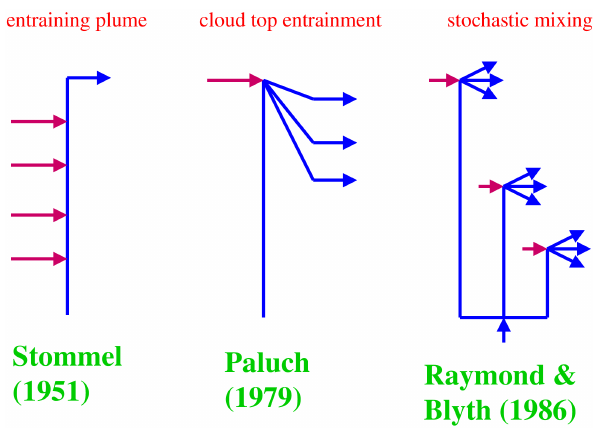
Figure 4. A schematic summary of the three different theories for the atmospheric convective entrainment–detrainment processes. From left to right: Stommel’s entraining plume, Paluch’s cloud- top entrainment, Raymond and Blyth’s stochastic mixing (based on Raymond,